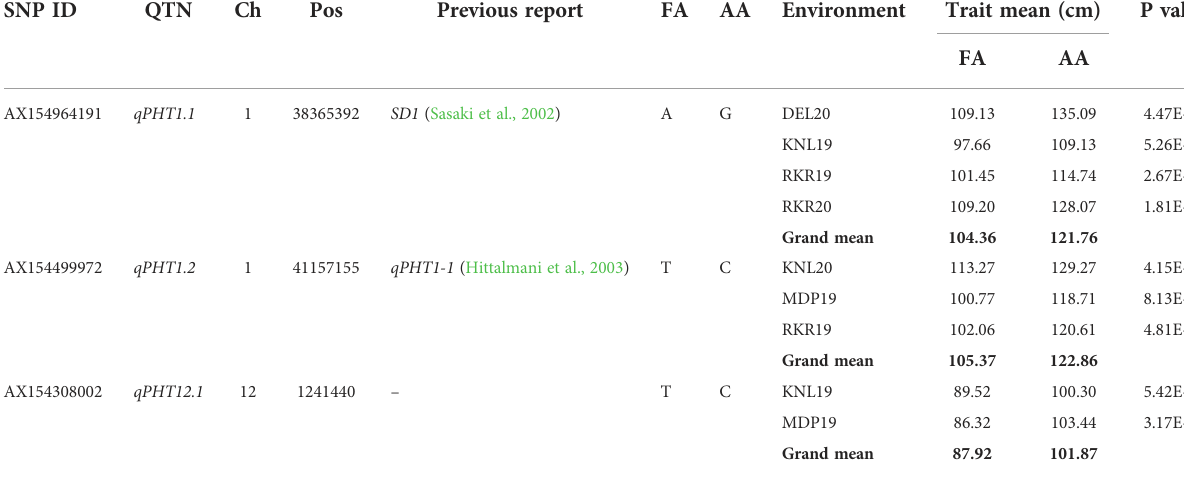
TABLE 7 Allelic effects of selected MTAs identi fi ed in multiple locations for plant height (PHT). SNP ID